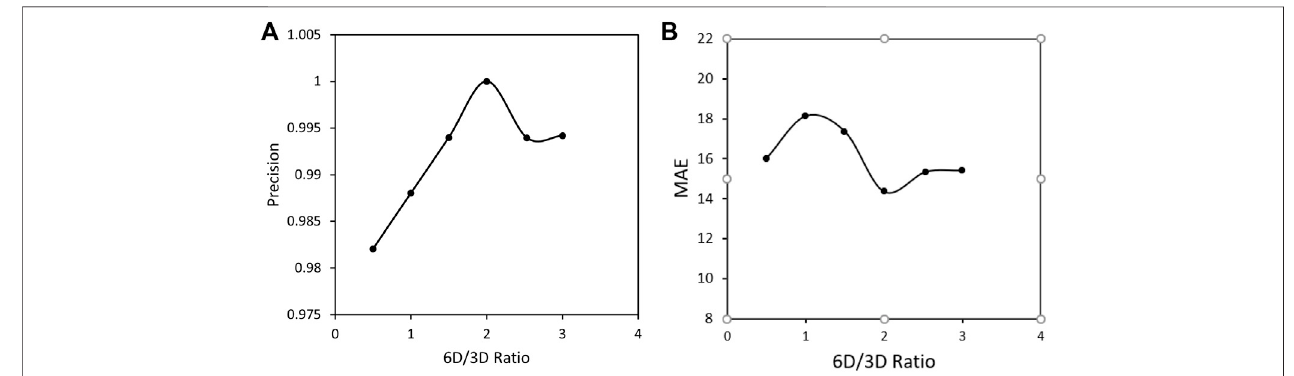
FIGURE8|(A) Precisionand (B) MeanAbsoluteerroraftertrainingwithtotalnumberof300loadcasesindifferentratiosofloadcasesinfullstressspaceandextra cases in principal